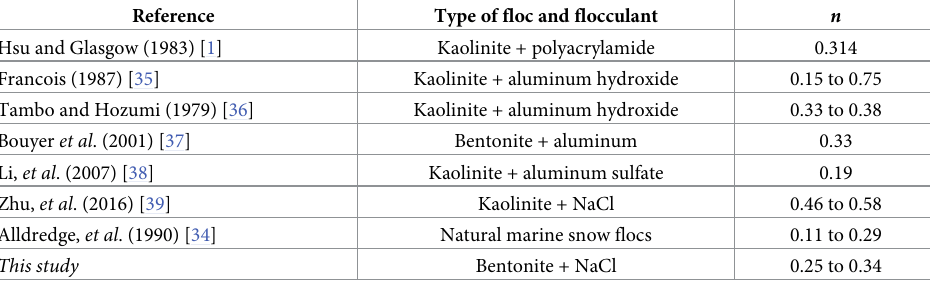
Table 1. Strength exponents for clay flocs from the